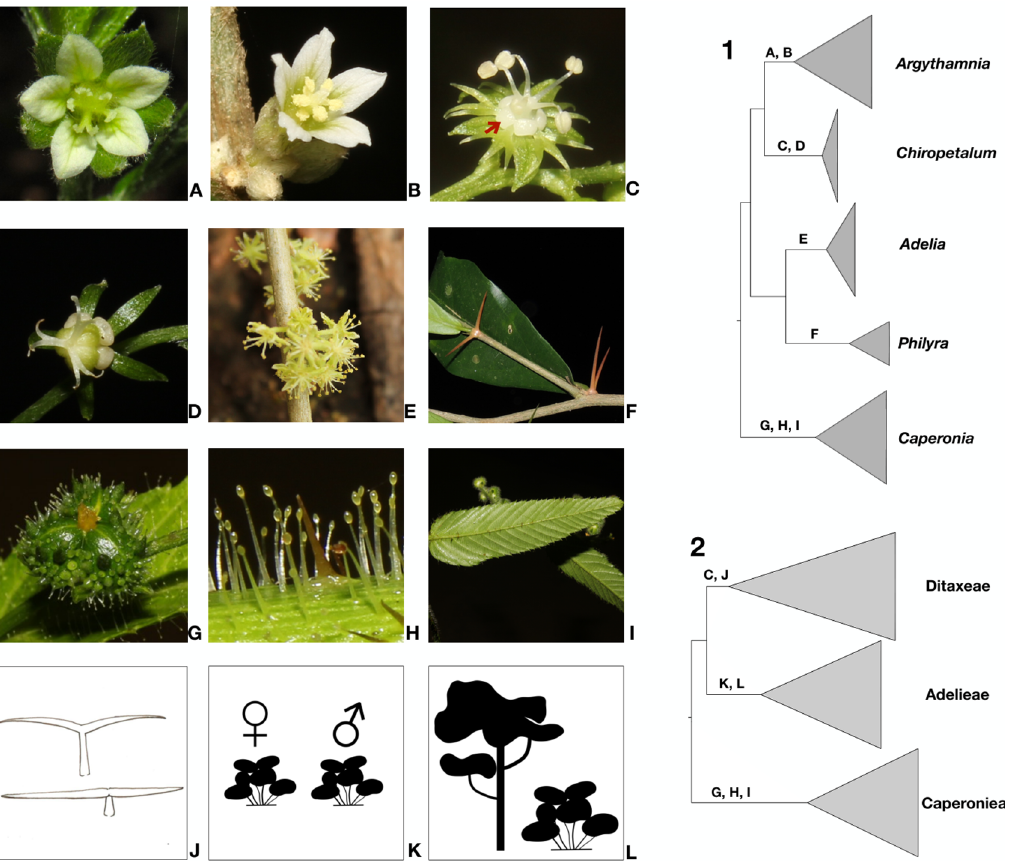
Figure 2. Schematic phylogenies of Ditaxinae and related taxa based on Bayesian inference using the combined five markers (cpDNA [ trn LF, trn TL, pet D] and nDNA [ETS, ITS]). 1 & 2. Generic (1) and suprageneric (2) classifications proposed here. Letters on branches indicate the morphological synapomorphies supporting each clade corresponding to the following illustrations. ( A ) Dichlamydeous pistillate flower of Argythamnia desertorum . ( B ) Staminate flower with entire petals of Argythamnia desertorum . ( C ) Staminate flower with lobed petals of Chiropetalum phalacradenium for cladogram 1 and floral nectaries for cladogram 2. ( D ) Monochlamydeous pistillate flower of Chiropetalum phalacradenium . ( E ) Monochlamydeous staminate flowers of Adelia membranifolia . ( F ) Pair of thorns below the leaves in Philyra brasiliensis . ( G ) Ovary with muricate surface in Caperonia heteropetala . ( H ) Glandular trichomes in Caperonia heteropetala . ( I ) Leaves with craspedodromous secondary veins in Caperonia heteropetala . ( J ) Malpighiaceous trichomes. ( K ) Dioecious sexual system. ( L ) Arboreal and shrubby habit.